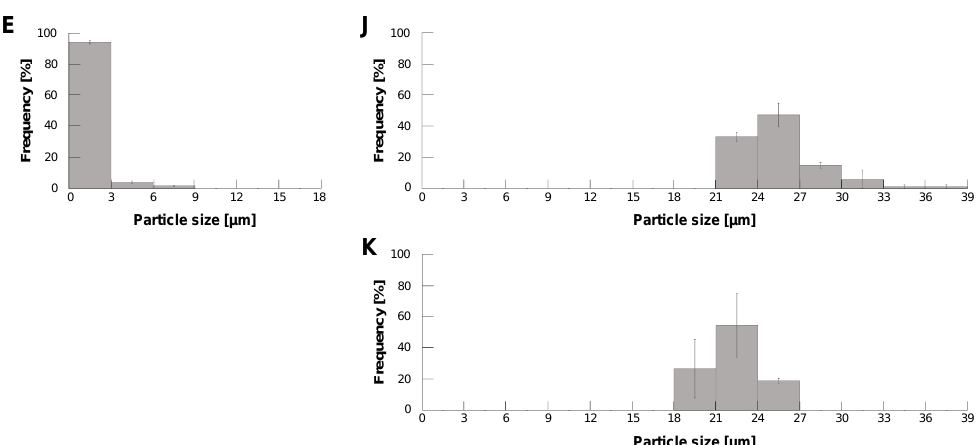
Figure 4. Particle size distribution of calcium alginate microcapsules with/without HeLa cells under different centrifugal forces. Size distribution of formed empty calcium alginate microcapsules ( A – E ), HeLa cells ( F ), formed calcium alginate microcapsules with HeLa cells ( G – J ), and formed calcium alginate microcapsules with 10µm polystyrene microbeads ( K ). ( A ). Formation of empty alginate microcapsules without glycerin capping for 1000 rpm. ( B , G ): 1000 rpm, ( C , H ): 2000 rpm, ( D , I ): 3000 rpm and ( E , J , K ): 4000 rpm (n =